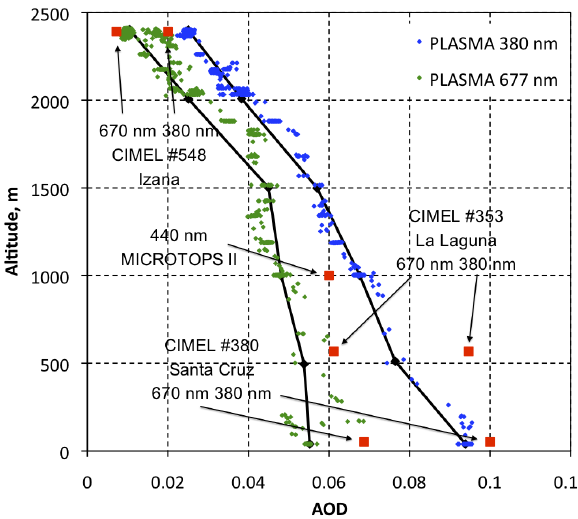
Fig. 5. Vertical profiles of AOD during automobile experiment 13 January 2011 on Tenerife island, Spain.